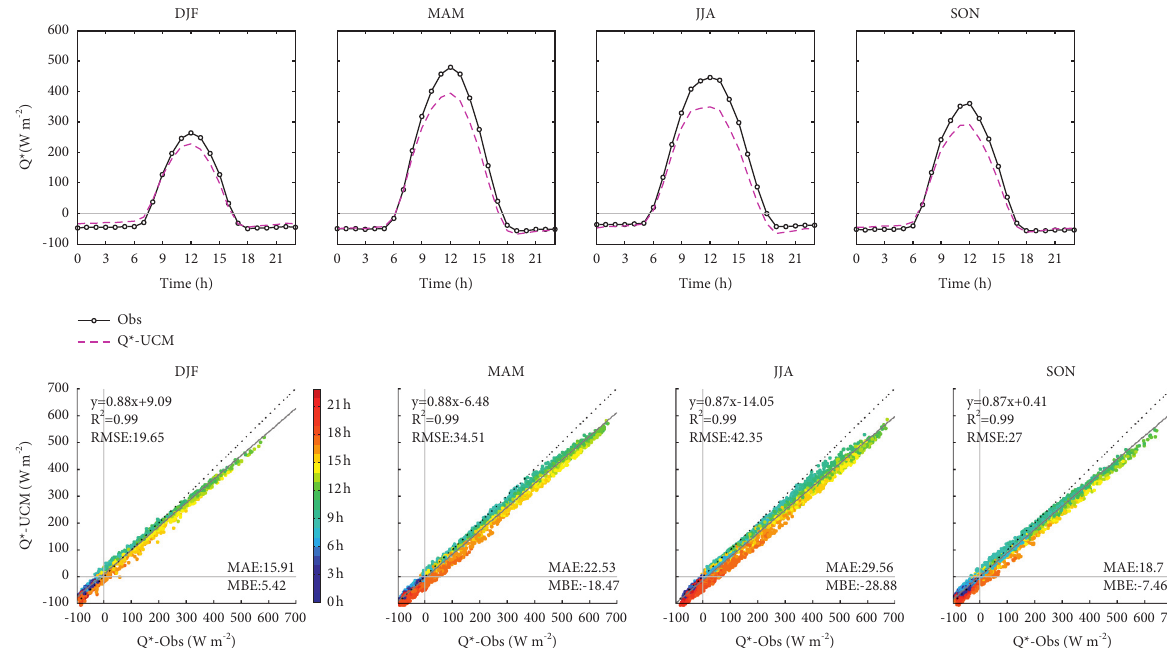
Figure 3: Observed (solid line) and SLUCM modeled (dotted line) seasonal mean diurnal curves of the net all-wave radiation flux ( Q ∗ , upper panel), and the lower panel is the corresponding scatter plot.